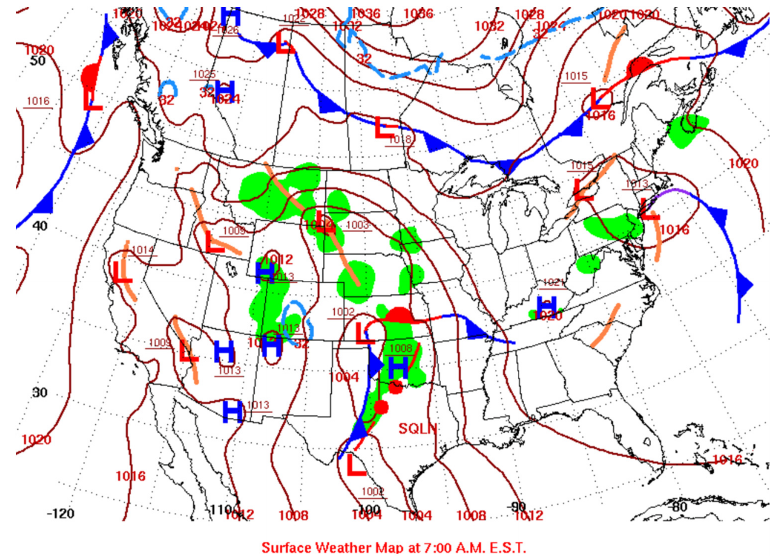
Figure 2. Surface weather map at 1100 Coordinated Universal Time (UTC), 20 May 2011, generated from the NOAA Weather Prediction Center [33]. Symbols L and H mark the local low and high pressure centers. Contours are isobars at 4 hPa intervals. Green shadings mark the regions of precipitation in the previous 24 h.